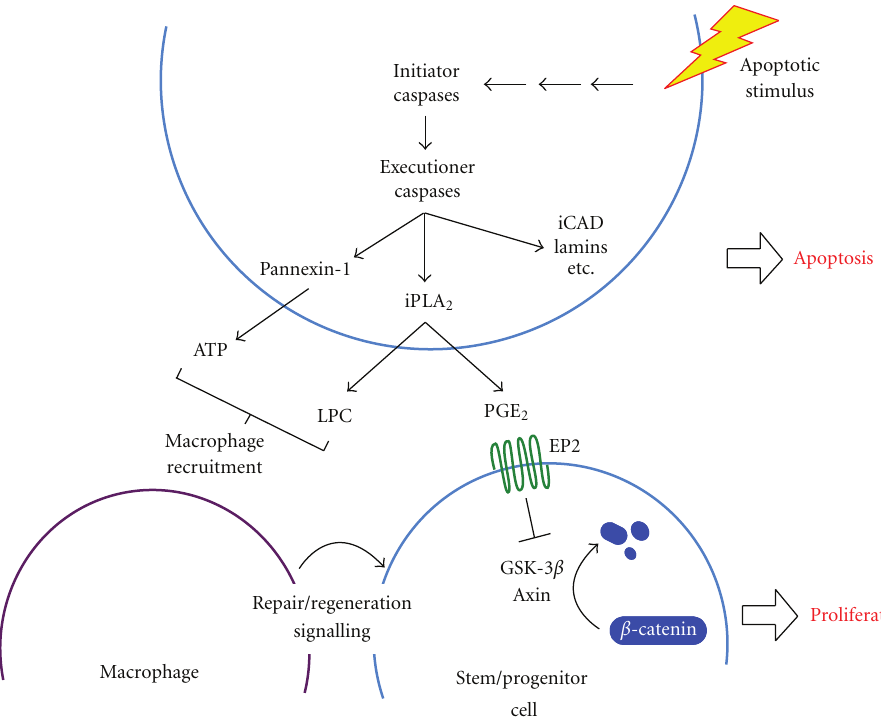
Figure 1: Apoptotic stimuli activate caspases, triggering the proteolysis of a large number of intracellular substrates. The cleavage of many of these, including iCAD and lamins, is necessary for the morphological and biochemical changes of apoptosis. Other substrates have as yet undefined roles, while the cleavage of iPLA 2 is critical for the paracrine signalling that induces compensatory proliferation. Cleavage of iPLA 2 increases its activity, so raising the levels of PGE 2 and LPC. PGE 2 in turn activates EP2 G protein-coupled receptors on stem or progenitor cells. Intracellular signalling downstream of EP2 activates β -catenin and leads to cell proliferation. LPC and ATP may indirectly induce compensatory proliferation through the recruitment of